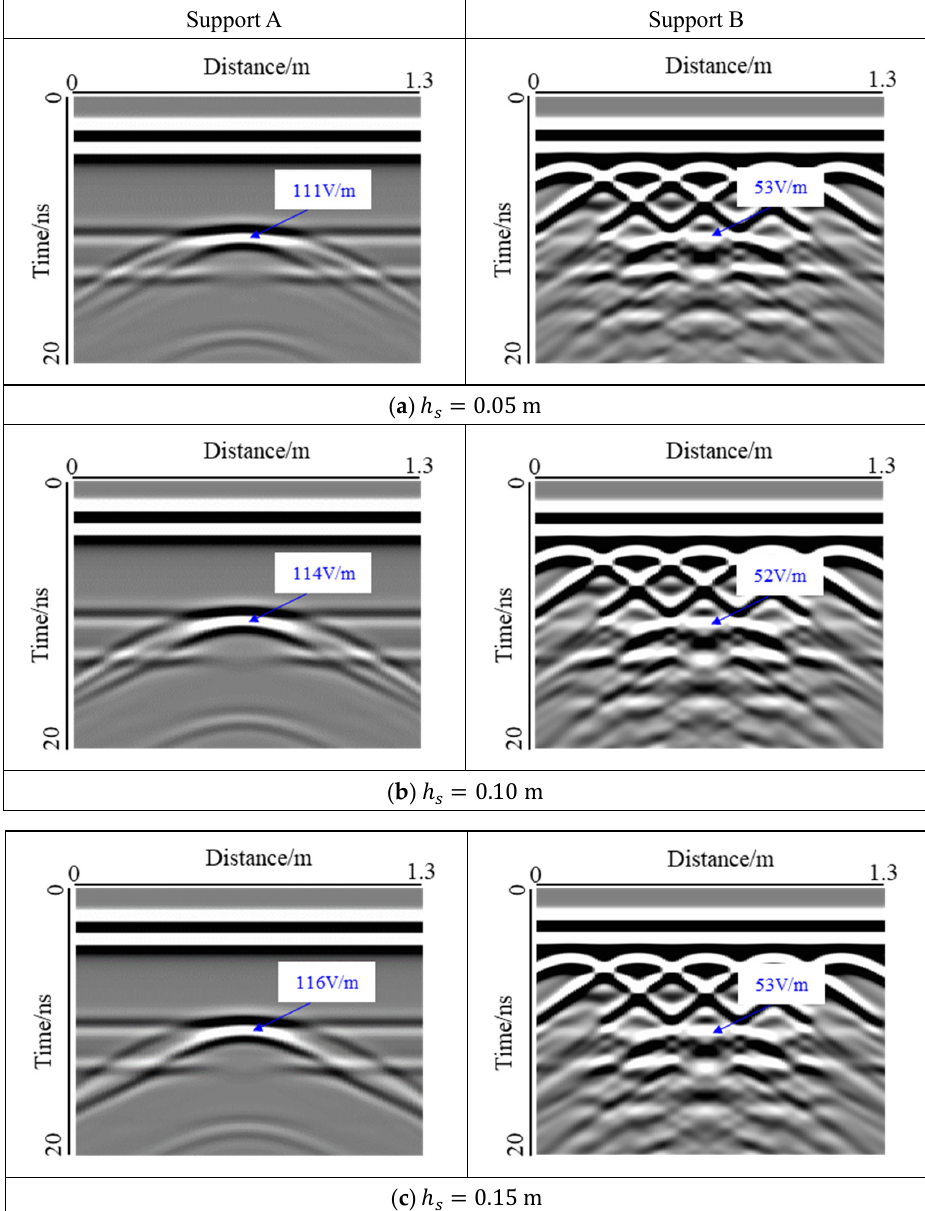
Figure 11. Influence of air ‐ filled void thickness at interface I. The figure shows that the thickness has little influence on the void response and electric field intensity; therefore, it is difficult to judge the void thickness by 2D GPR.